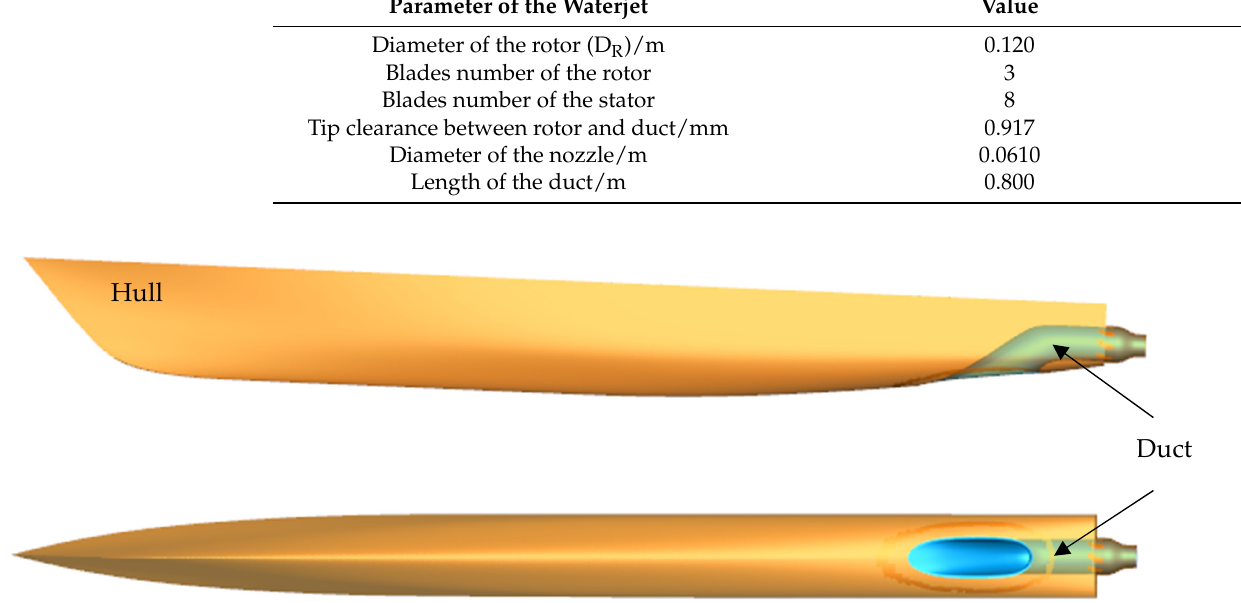
Figure 3. The demihull for the self-propulsion simulations.